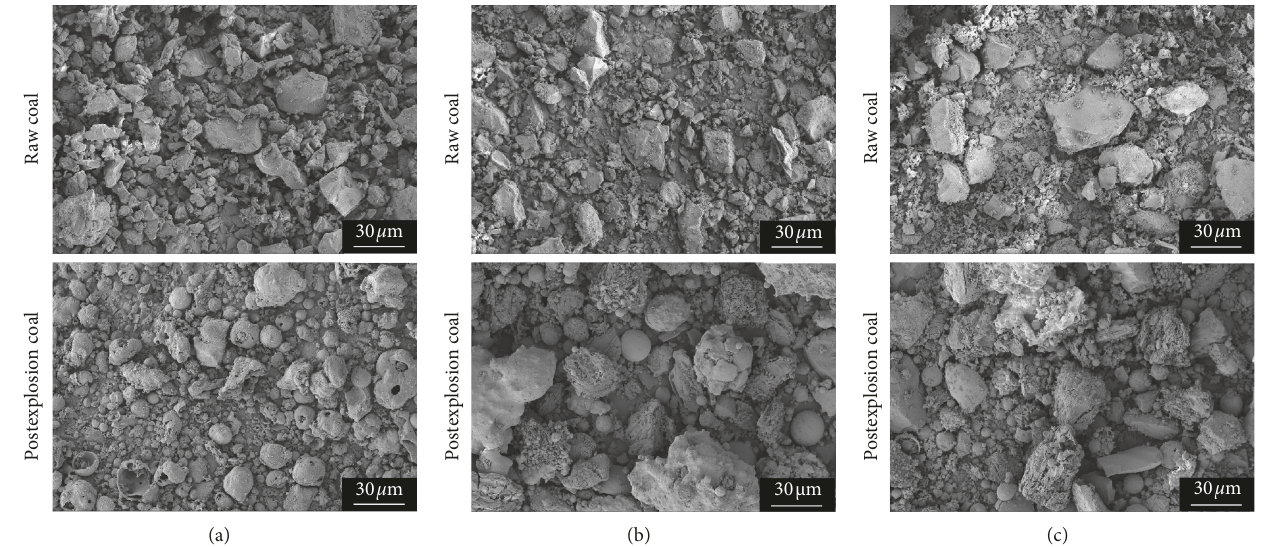
Figure 8: SEM images of the coal dust and their postexplosion products: (a) HM; (b) QM; (c) WY.